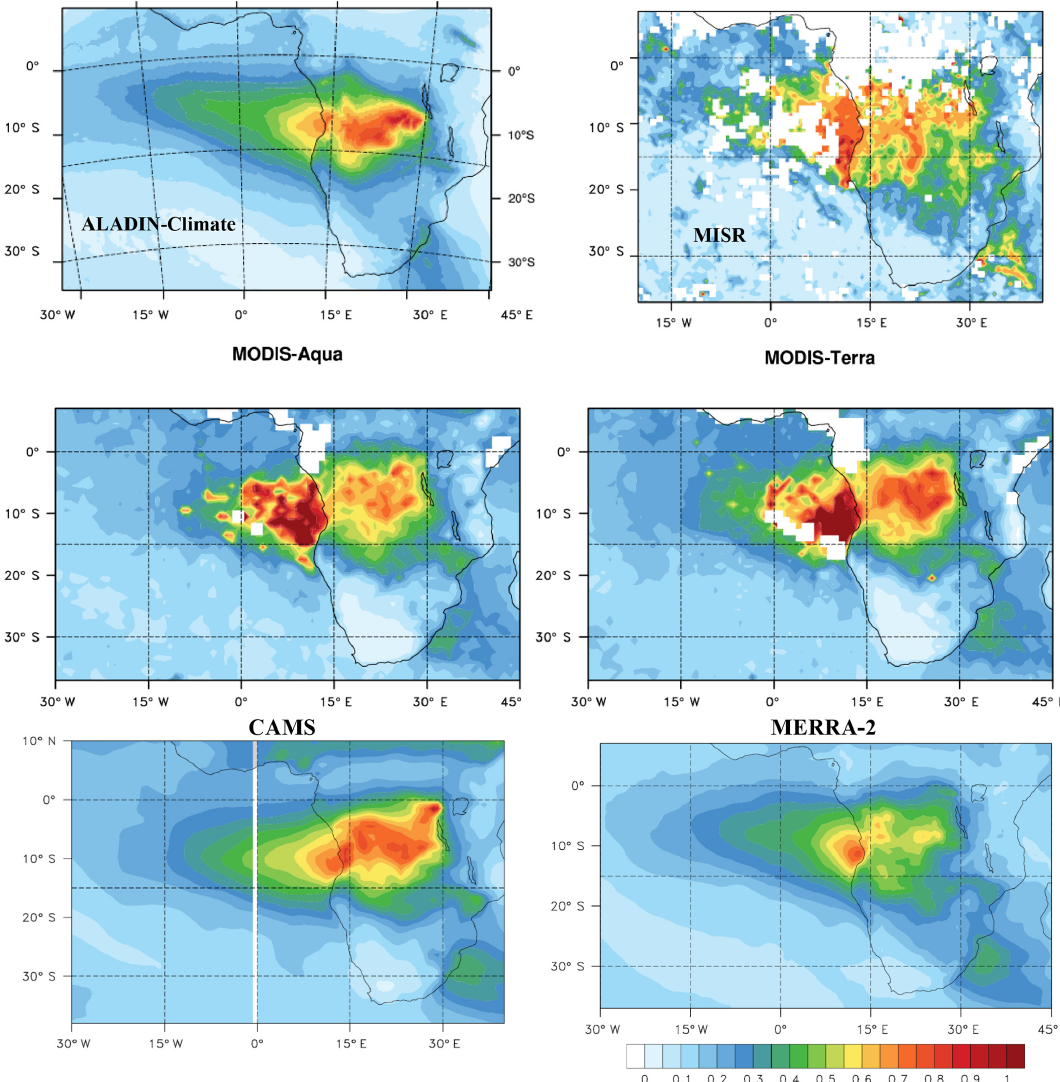
Figure 3. Total monthly averaged total AOD (at 550nm) for September 2016 simulated by ALADIN-Climate (all times used), CAMS, MERRA-2 and derived from the MODIS Terra, Aqua (combined DB/DT products) and MISR